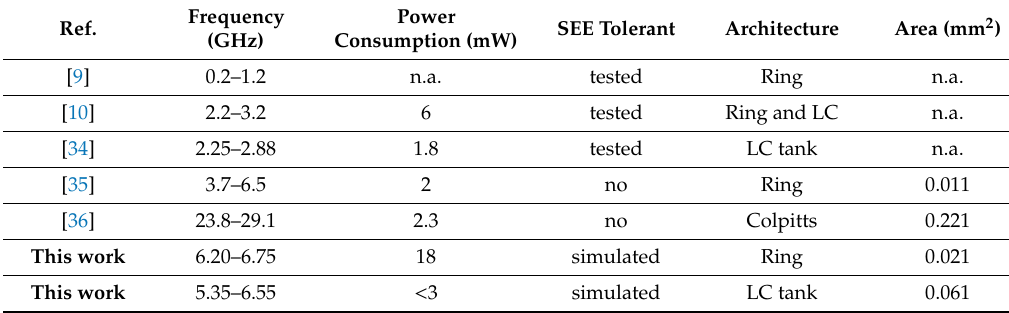
Table 3. State-of-the-art